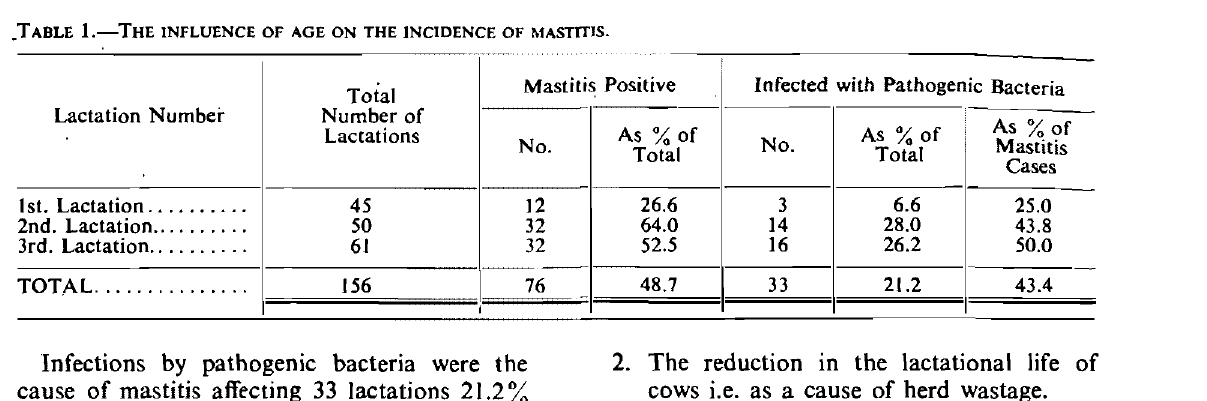
·TABLE I.-THE INFLUENCE OF AGE ON THE INCIDENCE OF MASTITIS.